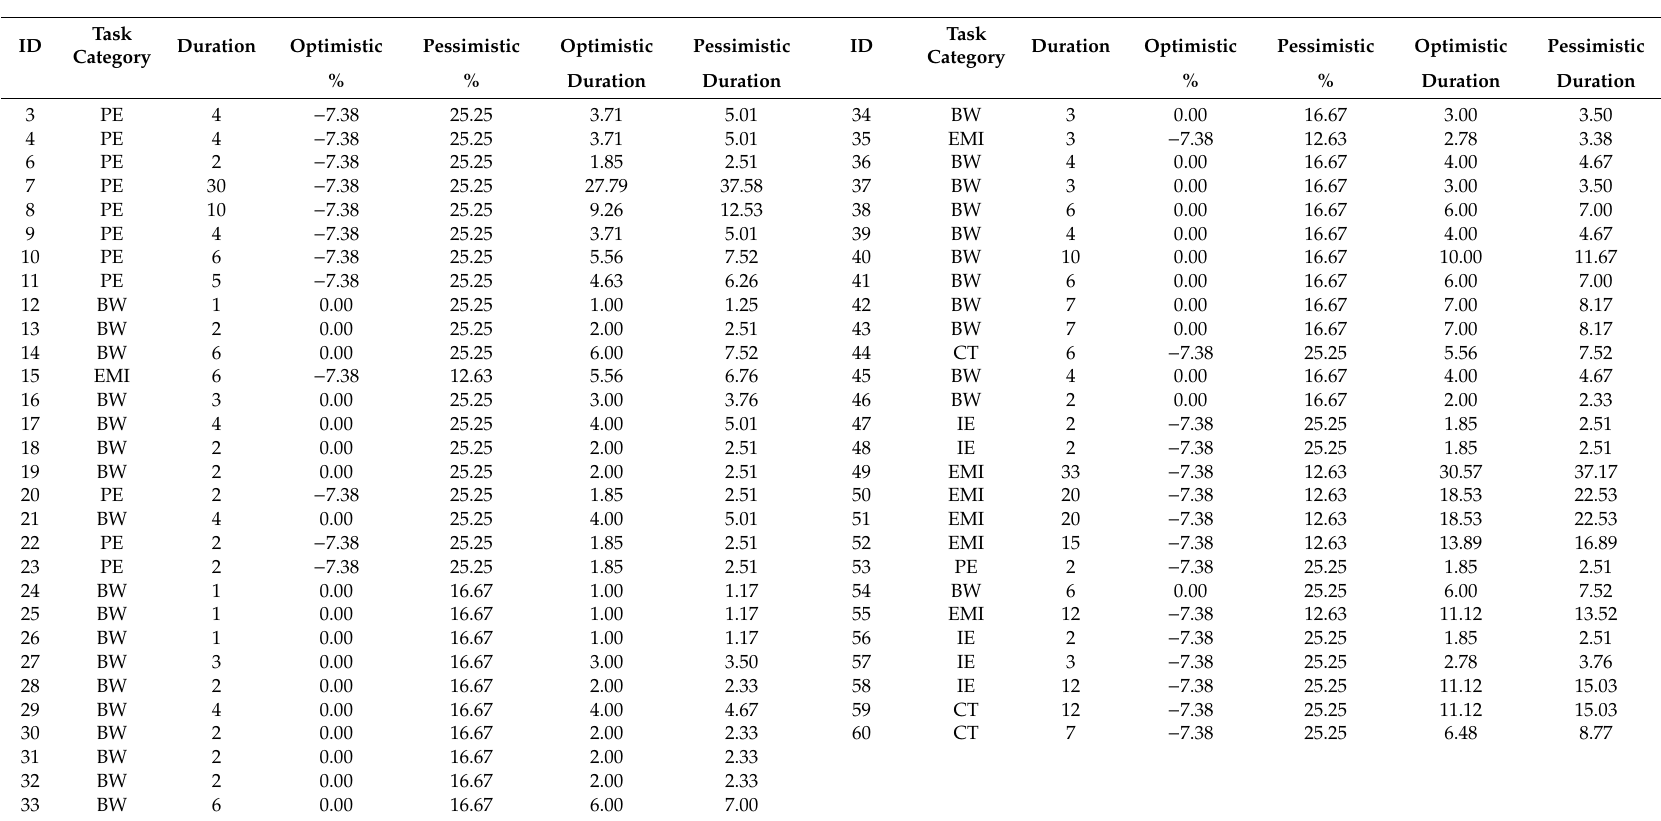
Table 7. The simulation input data for the project’s